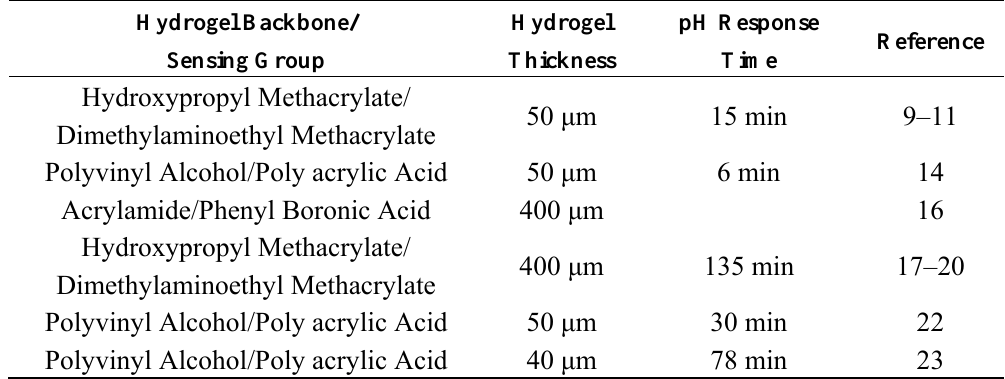
Table 1. A comparison of pH-responsive hydrogel results from reference projects with the composition, hydrogel thickness and response time of each